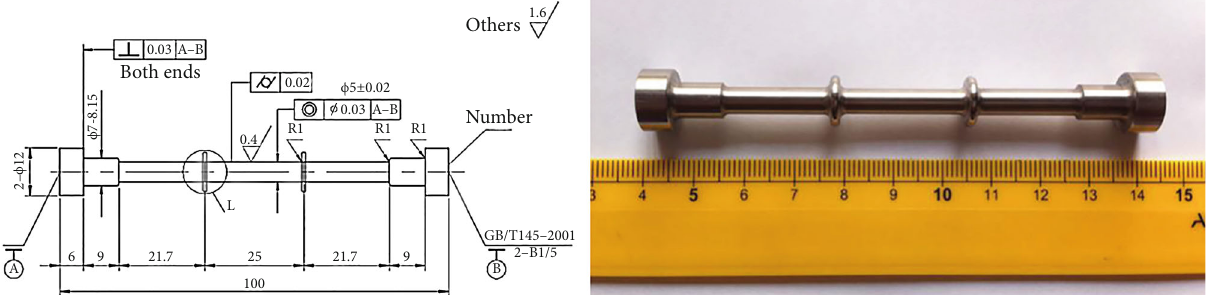
Figure 1: Schematic diagram of processed creep specimen and photo of high-temperature creep specimen.